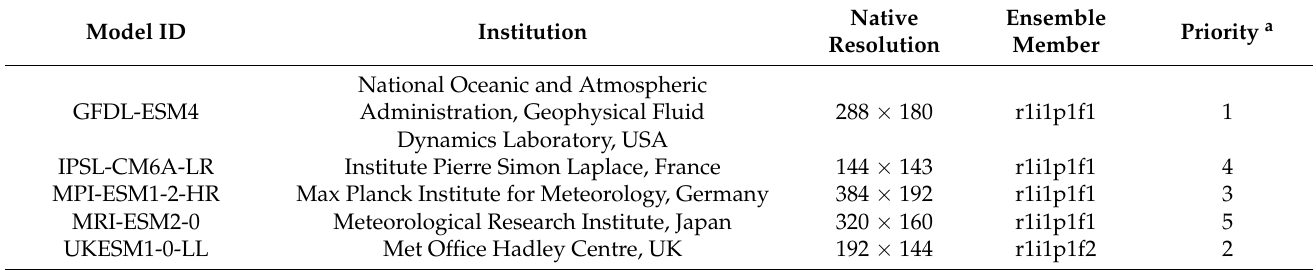
Table 3. Details of the primary five general circulation climate models used for the prediction of future habitat suitability of Spogostylum ocyale